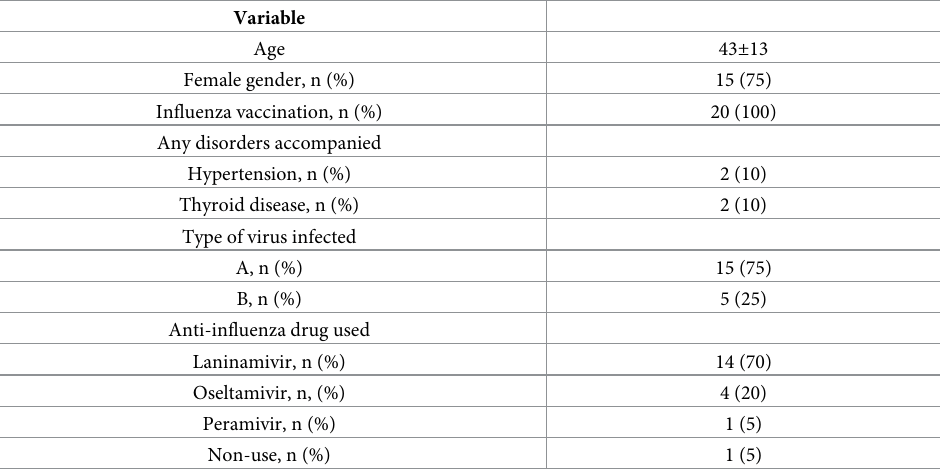
Table 2. Demographic characteristics of the study individuals.